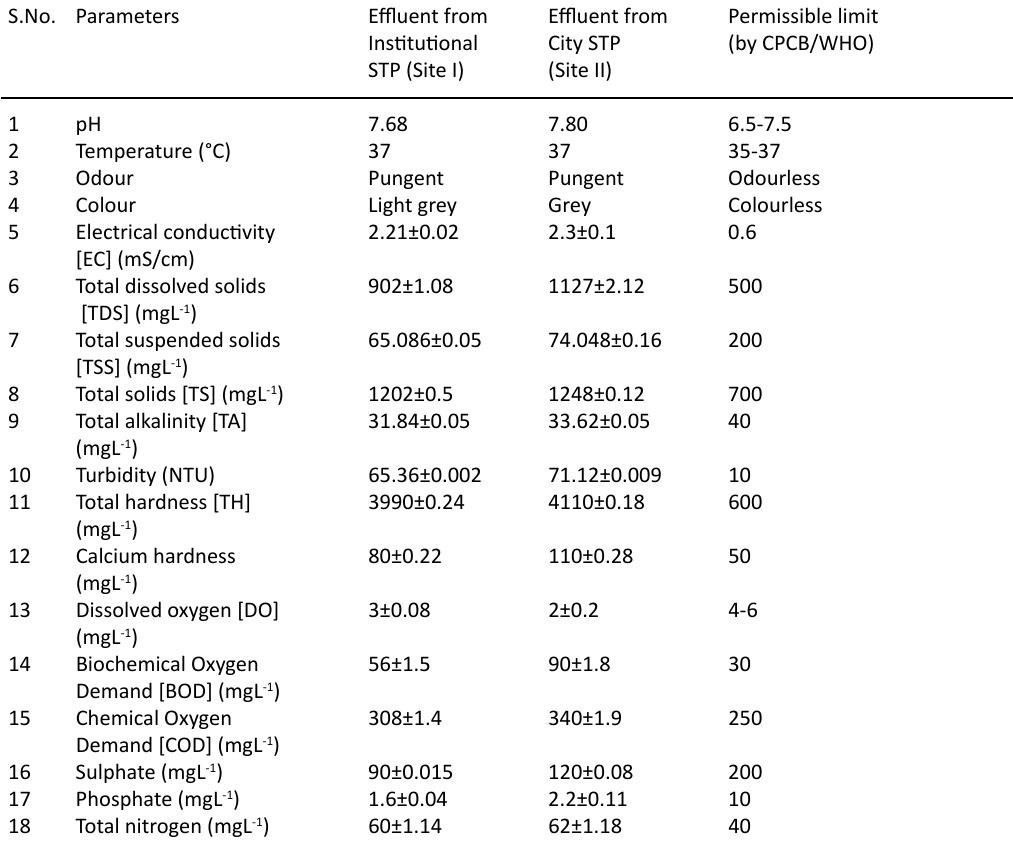
table 1. Physico-chemical characterization of the effluents S.No.